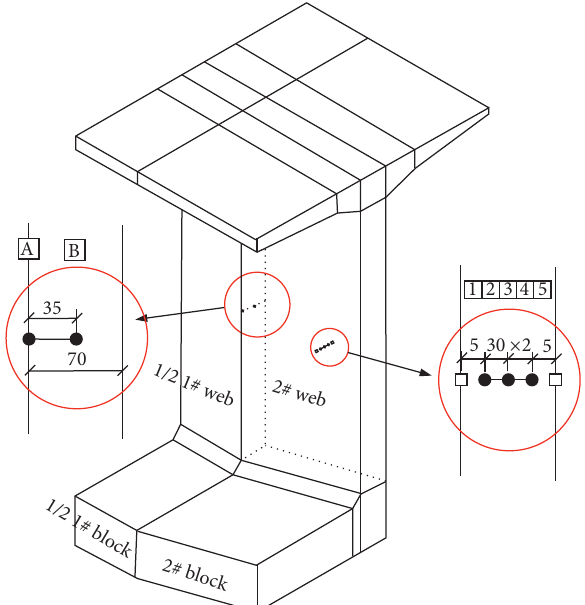
Figure 13: The hydration heat measured points and the positions of points A and B (unit: cm).